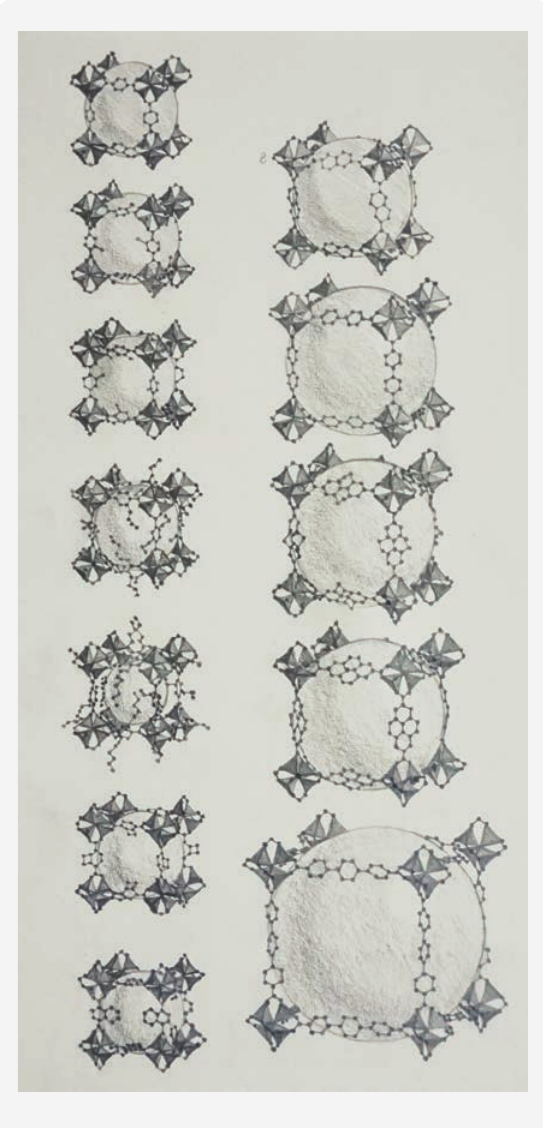
Fig. 3a. Isoreticular series of MOF-5 showing how the pores are functionalized and